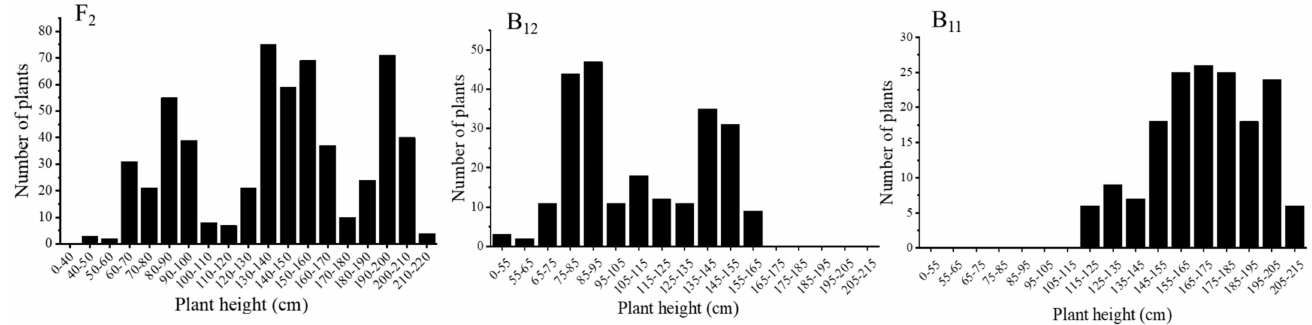
Figure 2. Distribution of plant height in the F 2 population and backcrosses. F 2 population ( left ) derived from the cross of ndf-2 and 3529. B 12 ( middle ) and B 11 ( right ) derived from the backcross of F 1 ( ndf-2 × 3529) with ndf-2 and 3529,